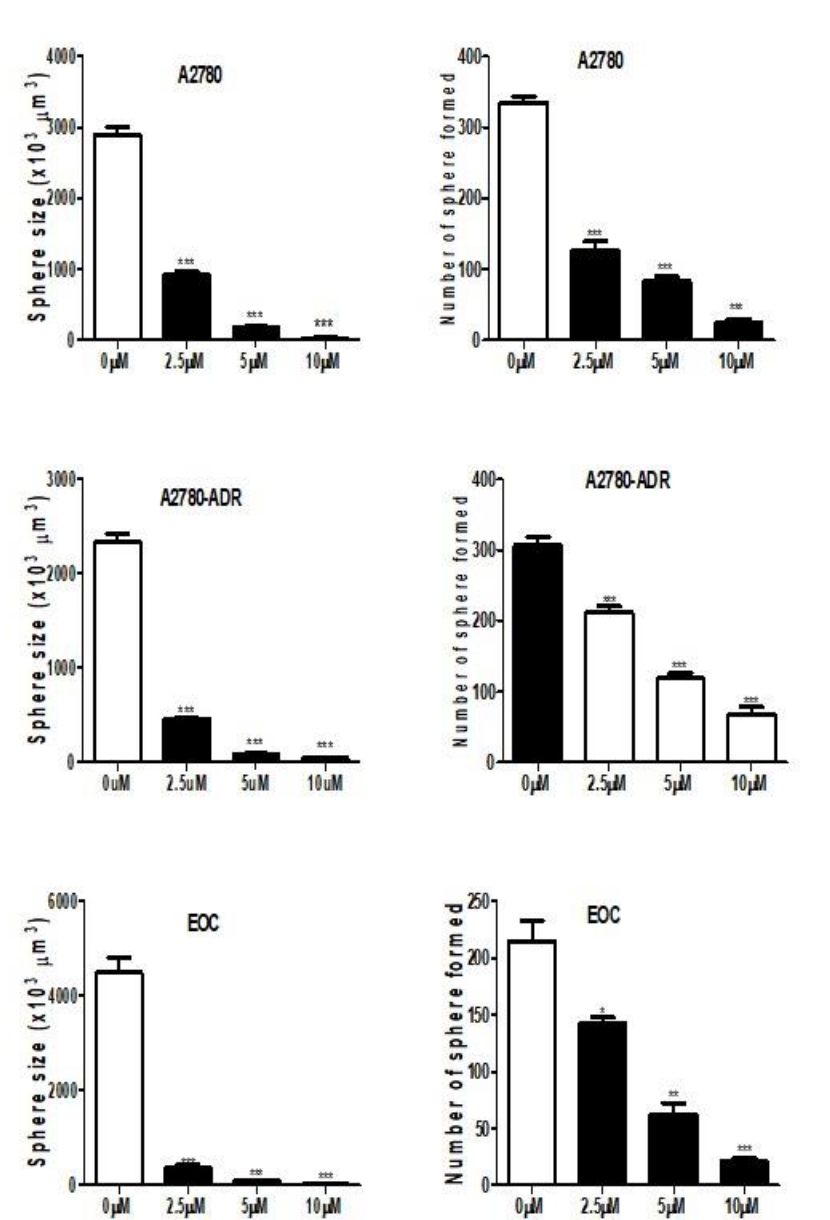
Figure 3. Etravirine inhibits ovarian cancer spheroid formation. Representative photomicrographs illustrate the effect of etravirine on spheroid growth at the indicated concentrations every two days for seven days in A2780, A2780-ADR, and EOC. Spheroid diameter and quantity were measured. Scar bar = 1000 µ m. Data are shown as mean ± SEM. * p < 0.05, ** p < 0.01, * ** p < 0.001.